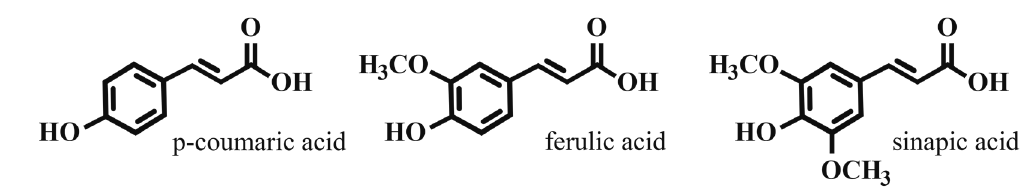
Figure 1. Hydroxycinnamic acid structures.